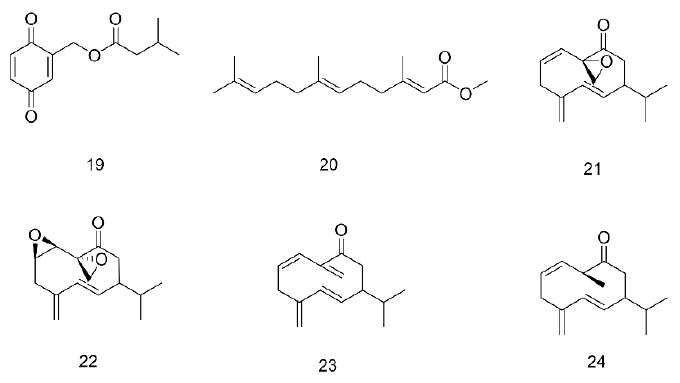
Figure 6. Terpenes isolated from the family Blattidae [64 – 66].